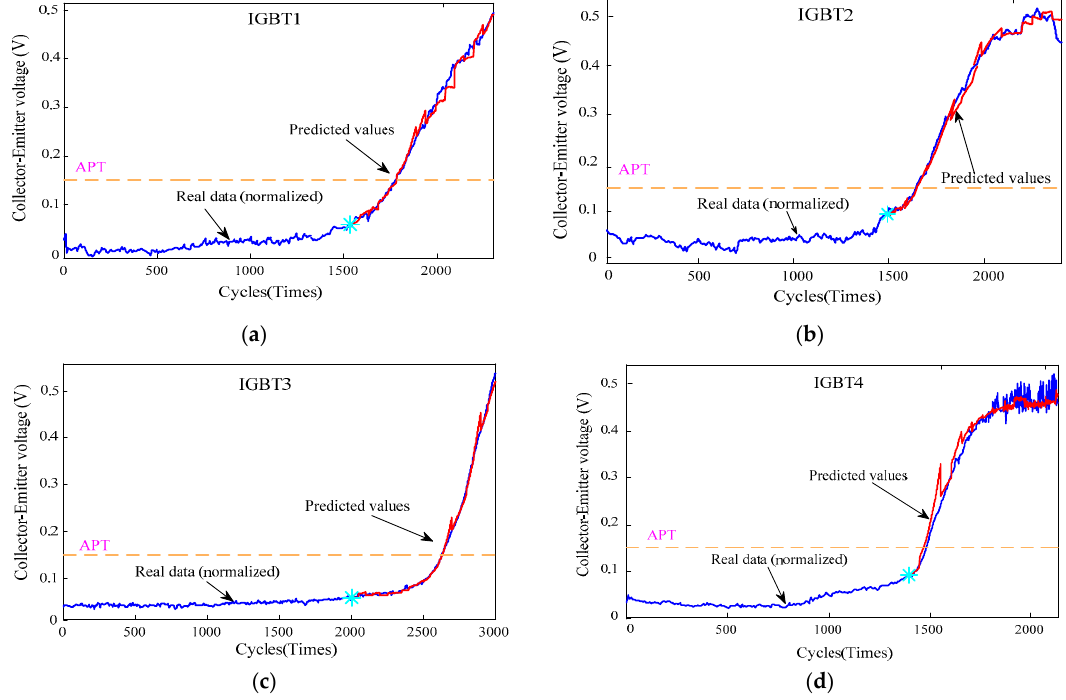
Figure 8. The 50-step-ahead prediction result: “true” (blue line), and predicted by VKOPP model (red line) (In each IGBT experimental dataset, two-thirds are taken for the training set). ( a ) The prediction result of the IGBT1; ( b ) The prediction result of the IGBT2; ( c ) The prediction result of the IGBT3; ( d ) The prediction result of the IGBT4.